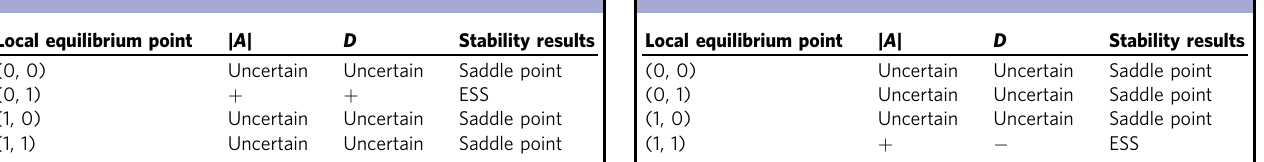
Table 6 System evolutionary stability analysis in Situation (4).